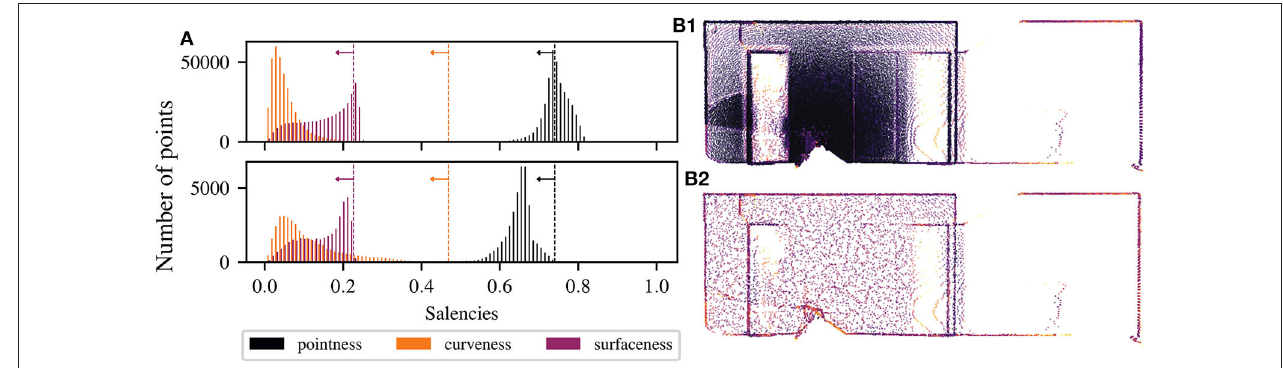
FIGURE 4 | (A) Convergence of the saliencies below their expected values, represented by the vertical dashed lines, implying a uniform density on each geometric ρ primitive. The used parameters are k 50 and σ 0.2. The top-histogram represents the initial saliencies distribution obtained from the tensor voting framework. = = = The bottom-histogram shows the resulting distribution after making the density uniform. Illustration of the process of reducing and making uniform a structured point cloud from 370 k (B1) to 40 k points (B2) , i.e., a compression ratio of 89 %. The resulting point cloud have uniform density, and geometric primitives, such as corners, edges and surfaces, are